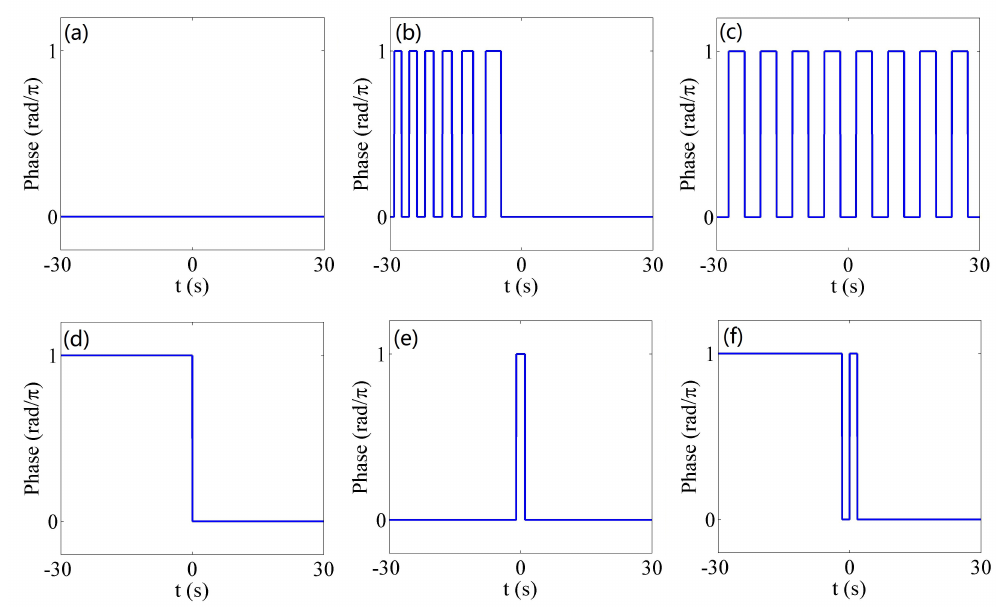
Figure 3. Envelope Envelope phases (blue curves) of different wavepackets presented in this chapter for x = 0. ( a ) Gaussian packet A ( t ) = exp ( − ( t / t 0 ) 2 ) , with duration t 0 = 2.0 s; ( b ) Airy wave packet A ( t ) = Ai ( t / t 0 ) exp ( α t / t 0 ) , with truncation α = 0.15 and width of main lobe t 0 = 2.0 s.